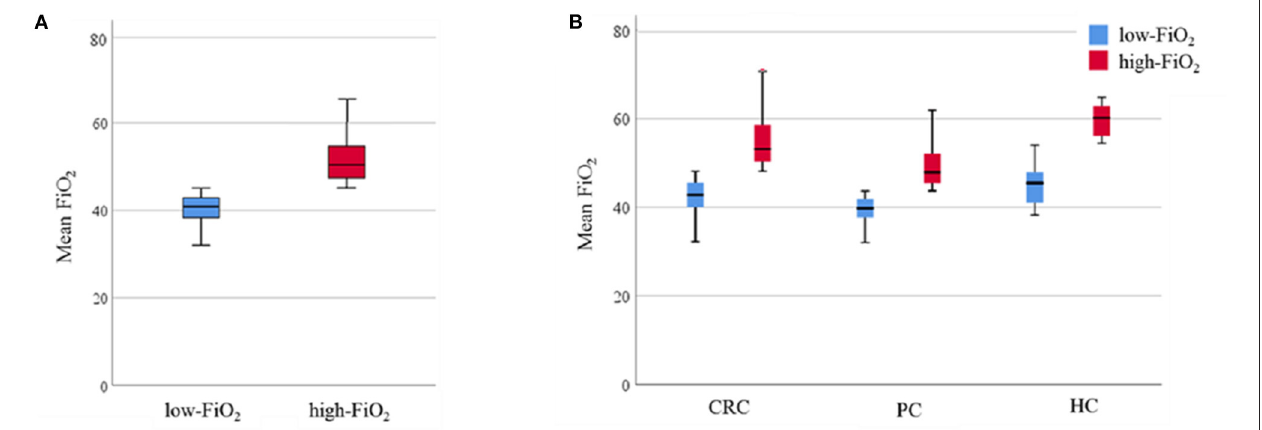
FIGURE 2 | Observed FiO 2 . Data are presented as median (interquartile range). Whiskers indicate the minimum and maximum values. P-values were tested using the non-parametric Mann-Whitney U test. (A) Intraoperative FiO 2 levels of the low-FiO 2 group compared to the high-FiO 2 group. (B) Intraoperative FiO 2 levels of the low-FiO 2 groups and the high-FiO 2 groups of each entity. FiO 2 , Fraction of inspired oxygen; CRC, Colorectal cancer; PC, Pancreatic cancer; HC, Hepatic cancer.